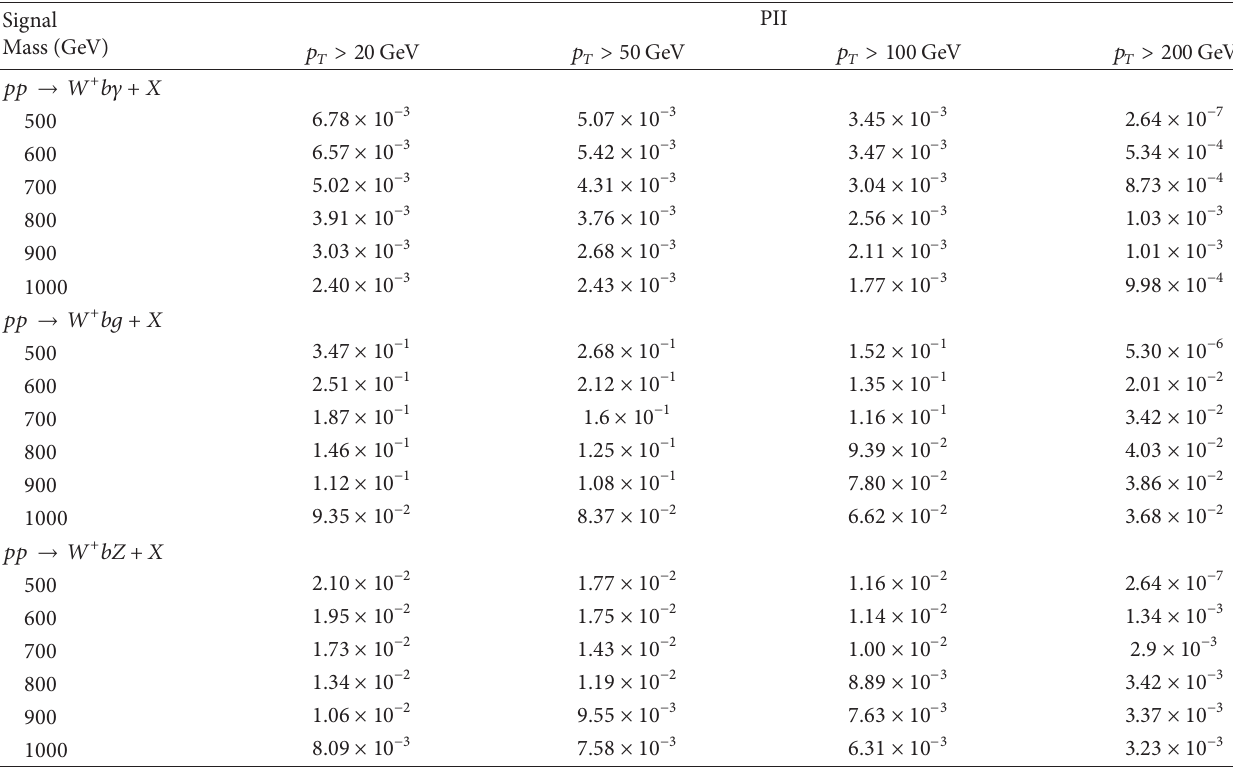
Table 8: The same as Table 7, but for parametrization PII.